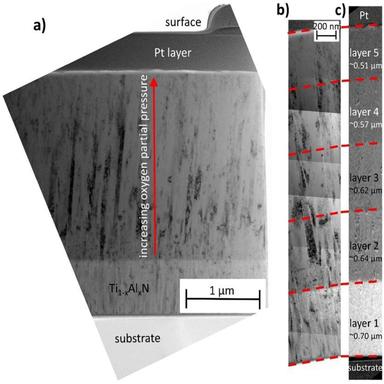
a) Bright-field TEM micrograph showing an overview of the graded TiAl(O)N film. b) Bright-field TEM micrographs of the graded TiAl(O)N film in higher magnification stitched together. c) Nitrogen jump ratio image of the graded TiAl(O)N film showing the five individual layers.